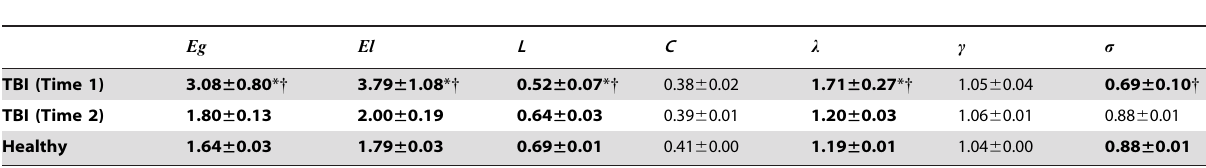
* indicates significant difference between Time 1 and Time 2. { indicates significant change from control group.